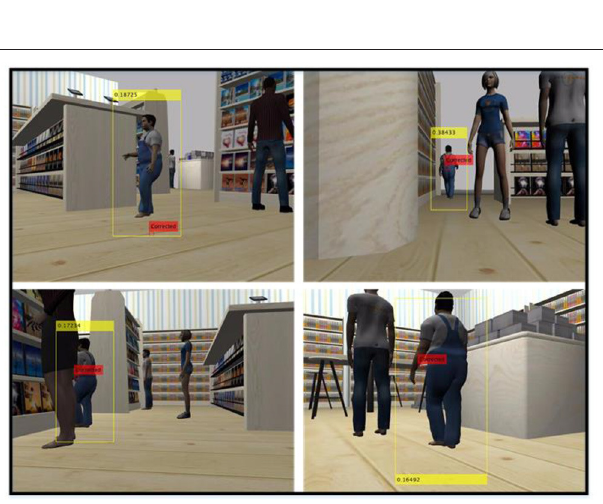
FIGURE 5 | Tracking of a customer in the mall with KF after human detection is completed with HOG-SVM.